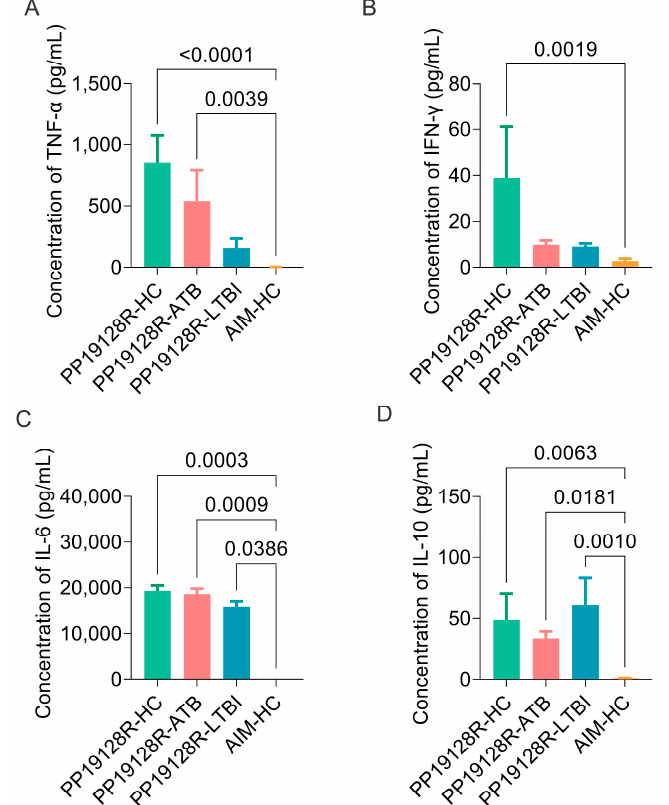
Figure 10. The levels of cytokines induced by the PP19128R vaccine. The purified PP19128R vaccine was used to stimulate PBMCs collected from HCs, ATB patients, and LTBI individuals in vitro. The levels of TNF- α ( A ), IFN- γ ( B ), IL-6 ( C ), and IL-10 ( D ) cytokines were detected with a BD CBA Human Th1/Th2/Th17 Cytokine Kit.